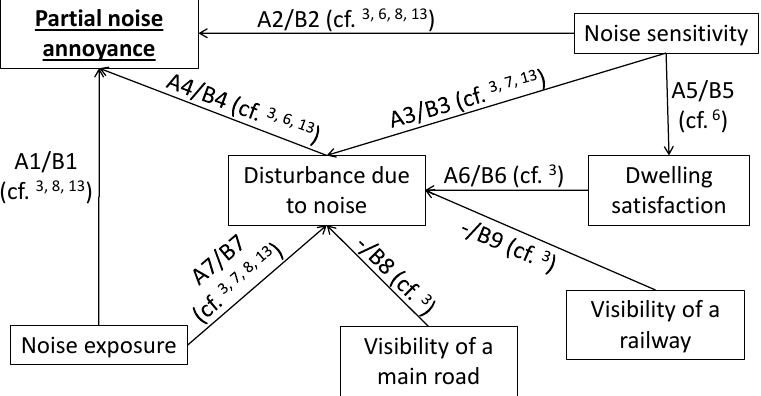
Figure 1. Structural equation model of partial noise annoyance without (Model A) and with (Model B) Visibility of noise source. A1 to A7 represent standardized coefficients in Model A, while B1 to B9 represent standardized coefficients in Model